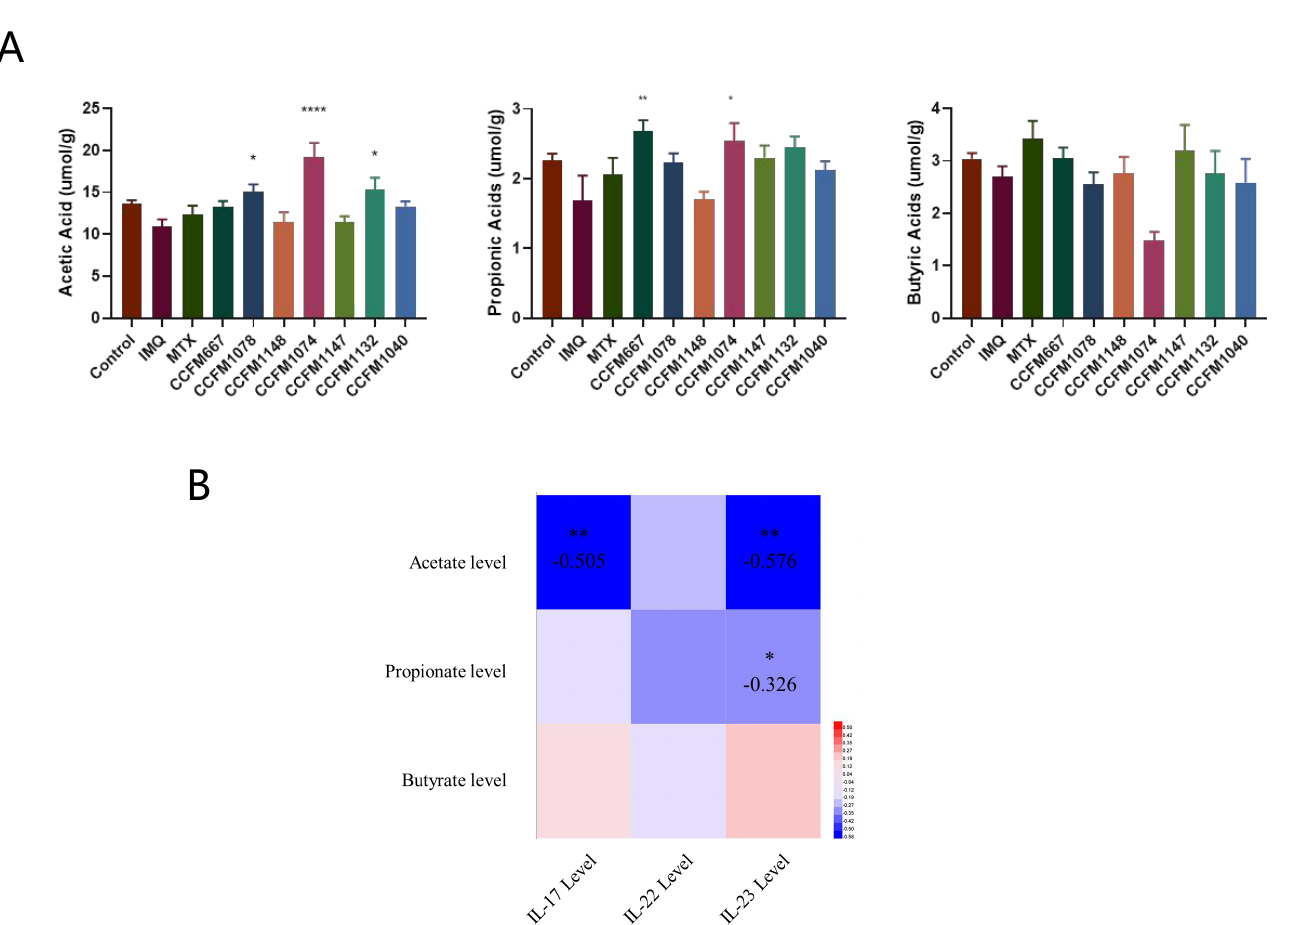
Figure 5. Effects of probiotics on short chain fatty acid metabolism. ( A ) Acetate, propionate, and butyrate levels in different groups ( n = 6). ( B ) Spearman correlation analysis between the levels of SCFAs and the levels of IL-23/Th17 axis-associated inflammatory cytokines. * p < 0.05, ** p < 0.01 and **** p <